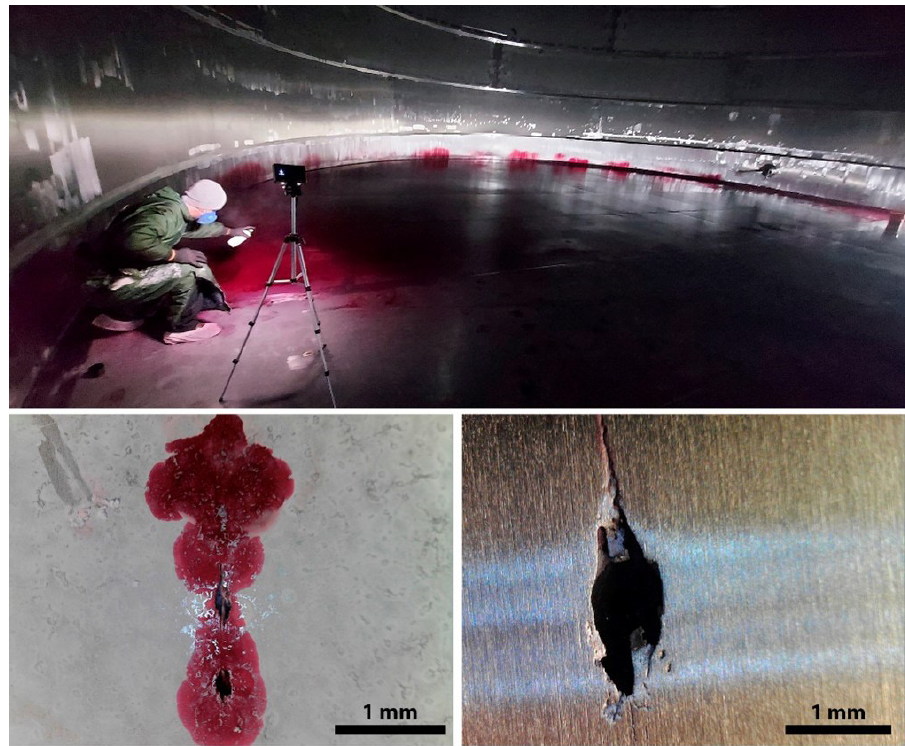
Figure 1. (a) Liquid penetration examination in progress and the respective surface corrosion defects, (b) liquid penetrant residues and (c) the surface after mechanical cleaning to take macrographic